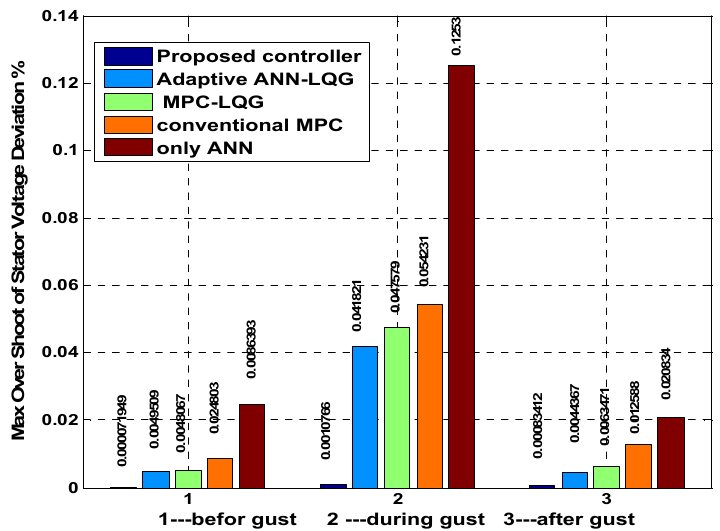
Figure 12. Max overshoot in generation power at different operating modes.